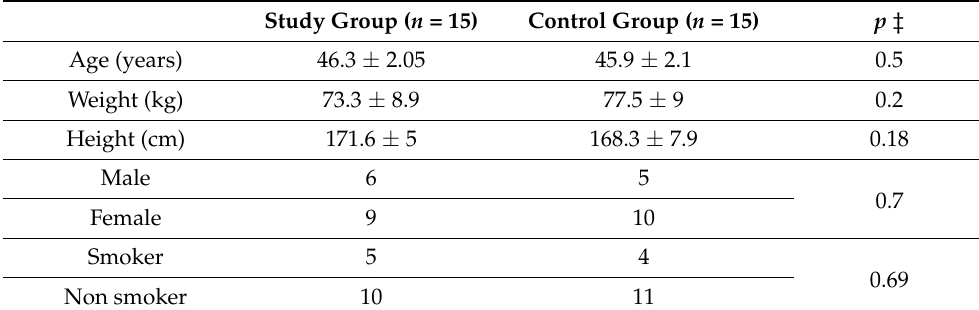
Table 1. Baseline participant